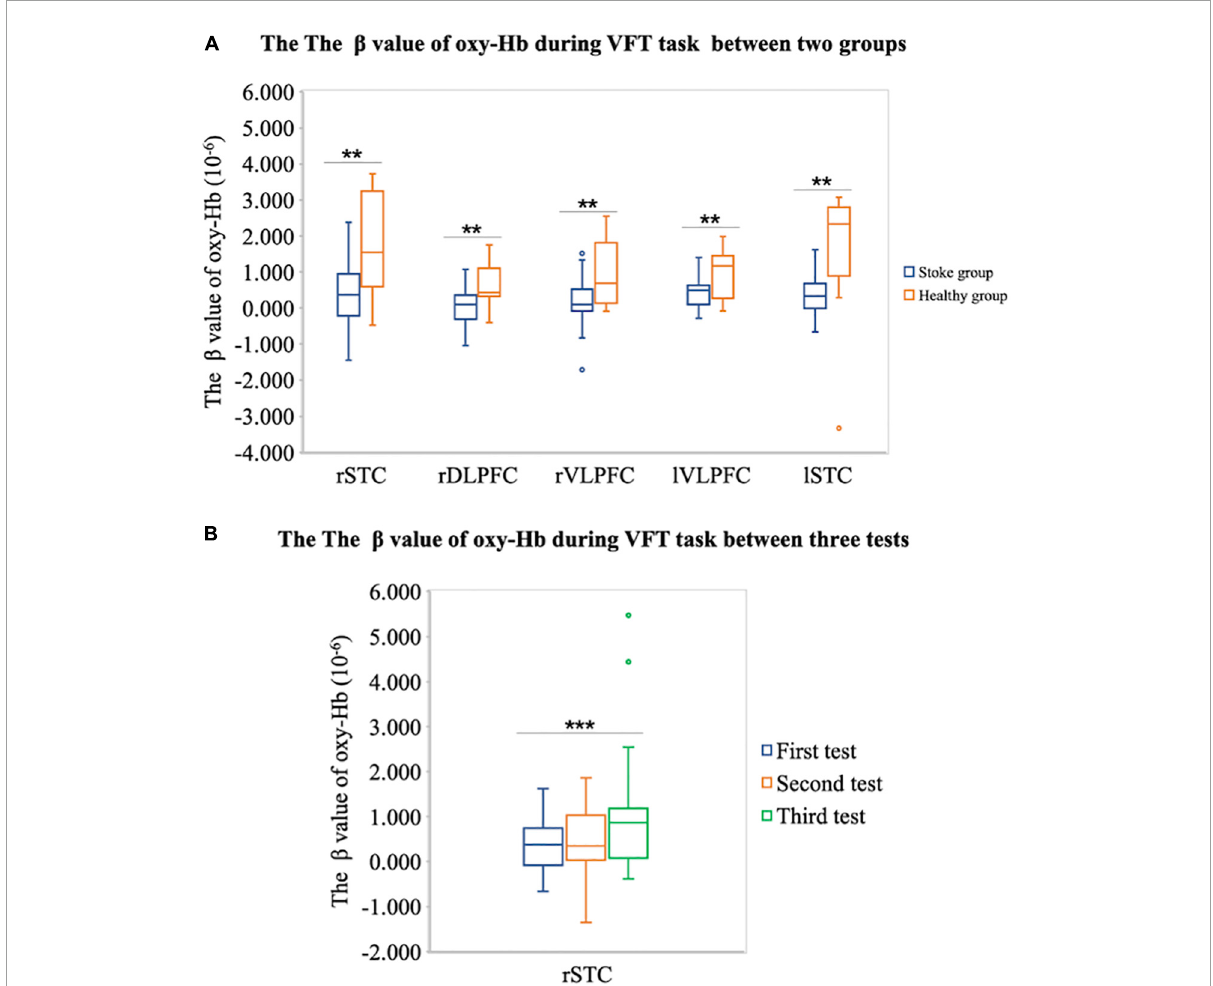
FIGURE5 (A) Difference of the β value of oxy-Hb during VFT between the stroke group and the healthy individual group on rSTC, rDLPFC, rVLPFC, and lVLPFC areas. (B) The difference of the β value of oxy-Hb on the right superior temporal cortex (rSTC) during VFT between three tests in patient with stroke. ∗∗ P < 0.05 and ∗∗∗ P <